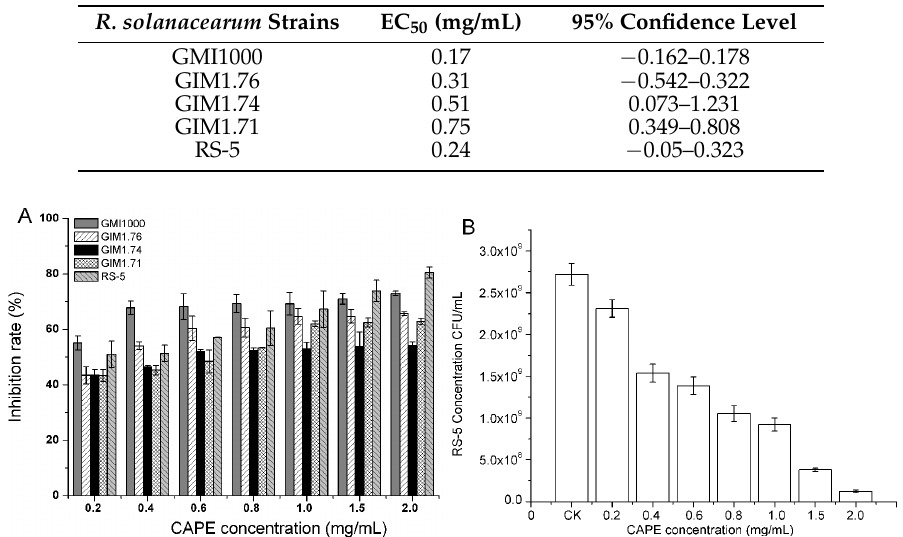
Figure 7. Bacterial growth inhibition (%) of CAPE against R. solanacearum strains including GMI1000, GIM1.76, GIM1.74, GIM1.71 and RS-5 measured at 600 nm ( A ), and the changes of mulberry bacterial wilt pathogen strain RS-5 treated by CAPE solutions with different concentrations tested by qPCR ( B ). Each value is expressed as the mean ± standard deviation ( n = 3).